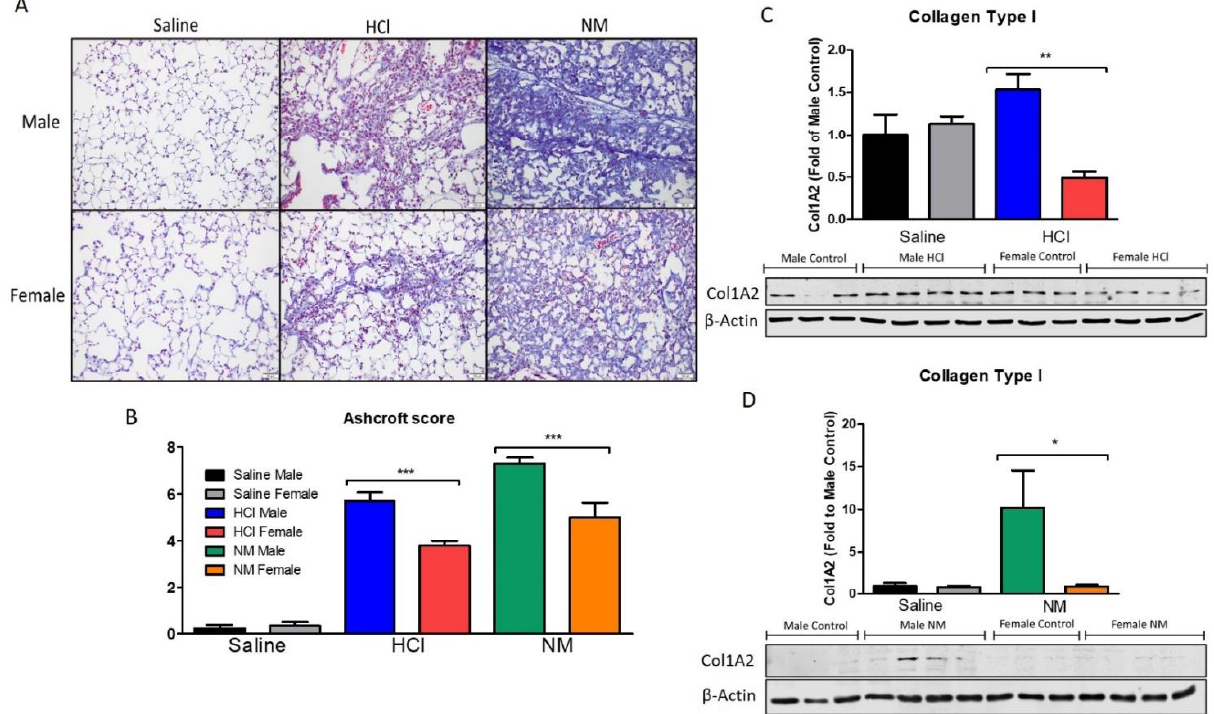
Figure 2. ( A ) Histological analysis of lung injury after intratracheal instillation of saline, NM, or HCl in male and female mice. Masson’s trichrome staining of lung sections at 30 days post-instillation. Male mice instilled with HCl displayed significant increase in perivascular collagen and loss of parenchymal architecture compare to control. Female mice showed formation of collagen fibers without severe breaking of parenchymal structures. Male mice receiving NM demonstrate increased parenchymal and perivascular collagen deposition and large areas with fibrous obliteration, while female NM- treated mice exhibited significantly less collagen staining. Scale bar: 100 µM. ( B ) Ashcroft scores of lung fibrosis; male mice have higher scores compared to females in both models of chemical exposure. ( C , D ) Collagen type I protein levels in female and male mice treated with either HCl ( C ) or NM ( D ) were analyzed by western Blotting. Male animals showed the highest collagen deposition in the lungs. Means ± SEM; *** p < 0.001; ** p < 0.01, * p < 0.05 with one-way ANOVA and Tuckey’s, n = 6.